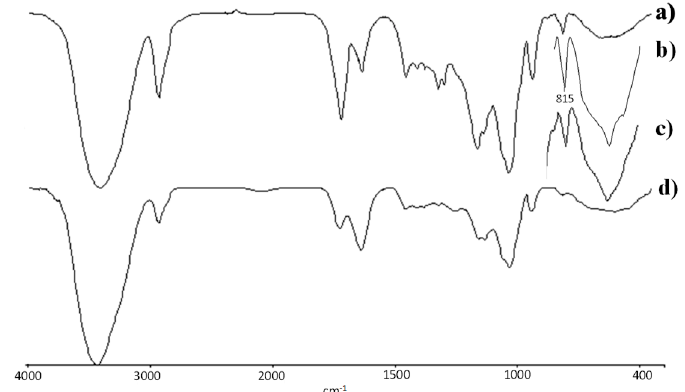
Figure 2. FTIR spectra of: ( a ) INVITEMA micelles; ( b ) crosslinked INVITEMA after 30 min UV irradiation still showing the presence of the acrylic double bond; ( c ) crosslinked INVITEMA system after 1 h UV irradiation still showing the presence of the acrylic double bond and ( d ) crosslinked INVITEMA system, spectra were acquired in transmittance. To improve the spectra readability only the acrylic bands at 815–816 cm − 1 for samples irradiated at 30 min or 1 h are inserted. 1 H-NMR spectra of INVITEMA conjugates, Figure 3, showed new peaks (with respect to native INU and INVITE) at 5.70 and 6.08 ppm belonging to MA vinyl protons (2H, s, CH 2 =R), Figure 3.